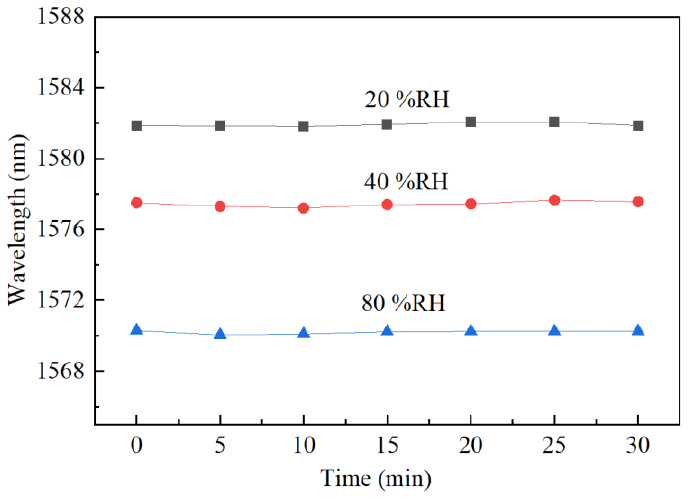
Figure 8. Stability test results of the FPI probe at different RH levels over 30 min.